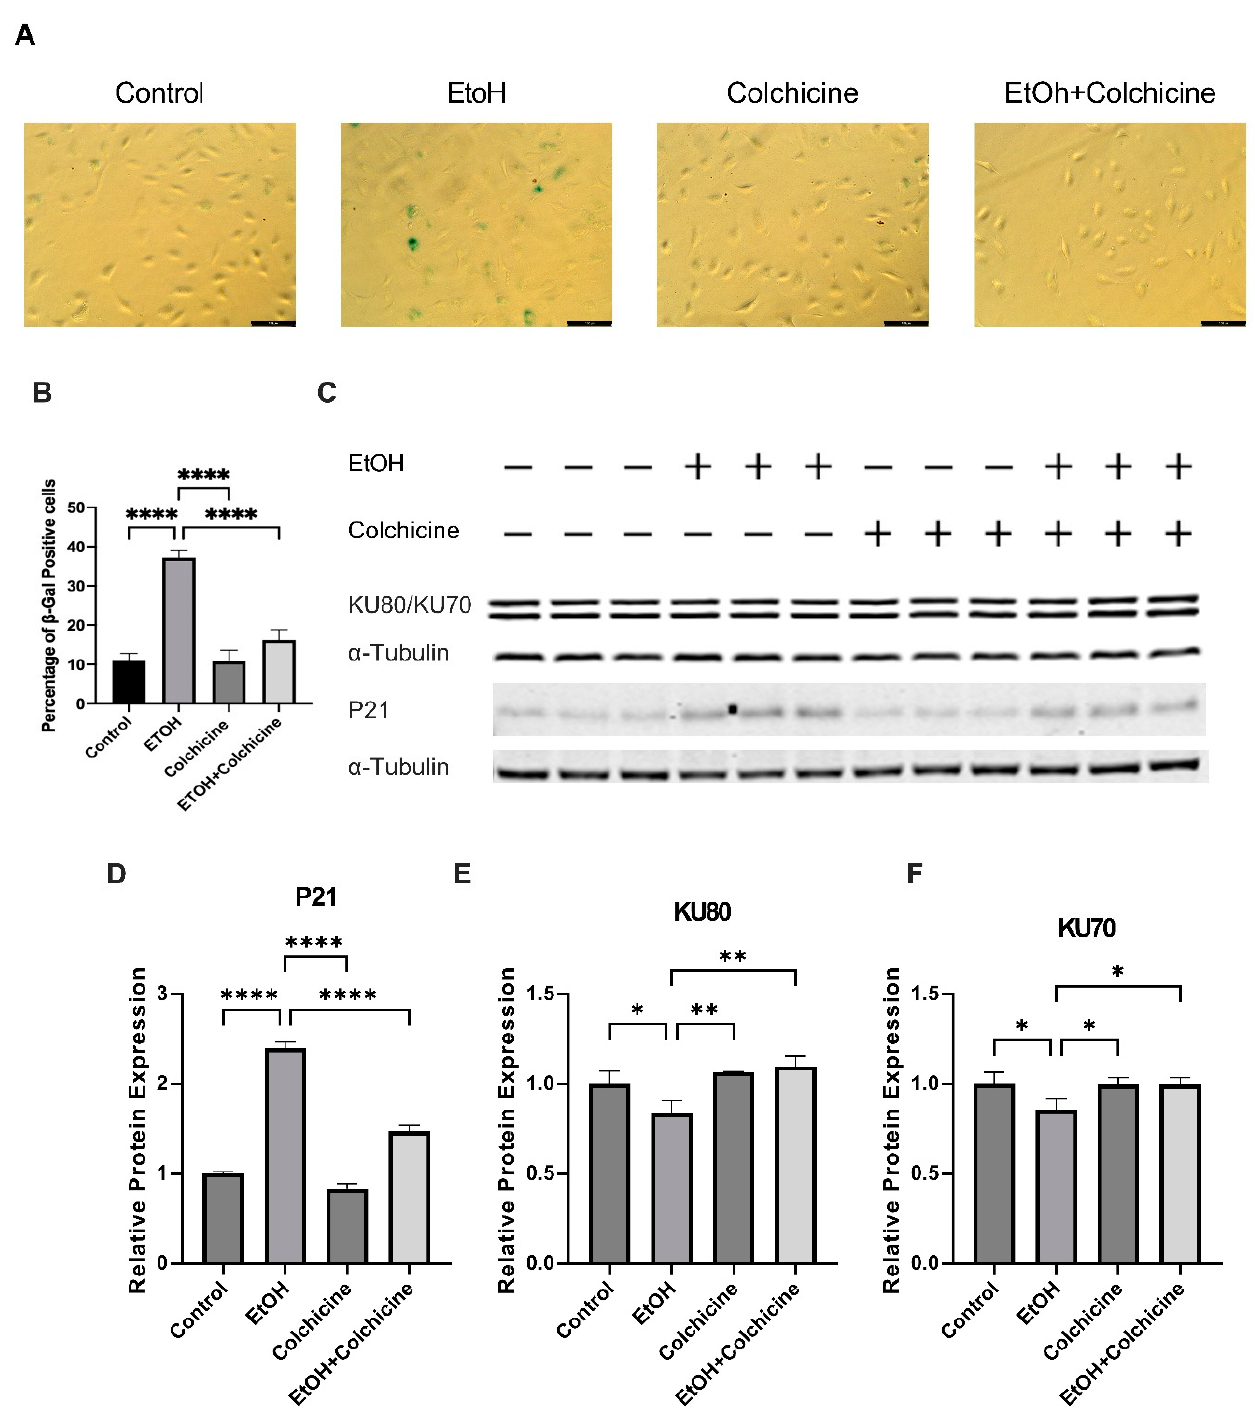
Figure 1. Colchicine inhibited endothelial senescence and restored the relative protein expression of aging-associated biomarkers. ( A ) Senescence in endothelial cells after 24 h of treatment with different conditions. ( B ) Colchicine subdued ethanol (EtOH)-induced senescence in endothelial cells. ( C ) Western blot showing protein expression of P21, KU80, and KU70. ( D ) Colchicine attenuated the relative protein expression of P21 in endothelial cells after ethanol exposure. ( E , F ) Colchicine recovered the relative protein expression of KU70 and KU80 in endothelial cells treated with ethanol. α -Tubulin was used as a loading control. Data are the mean of independent biological triplicates. The data was analyzed by performing one-way ANOVA followed by Tukey’s test. Scale bar = 100 µ m; error bars represent the SD (**** p < 0.0001, ** p < 0.01, and * p < 0.05).